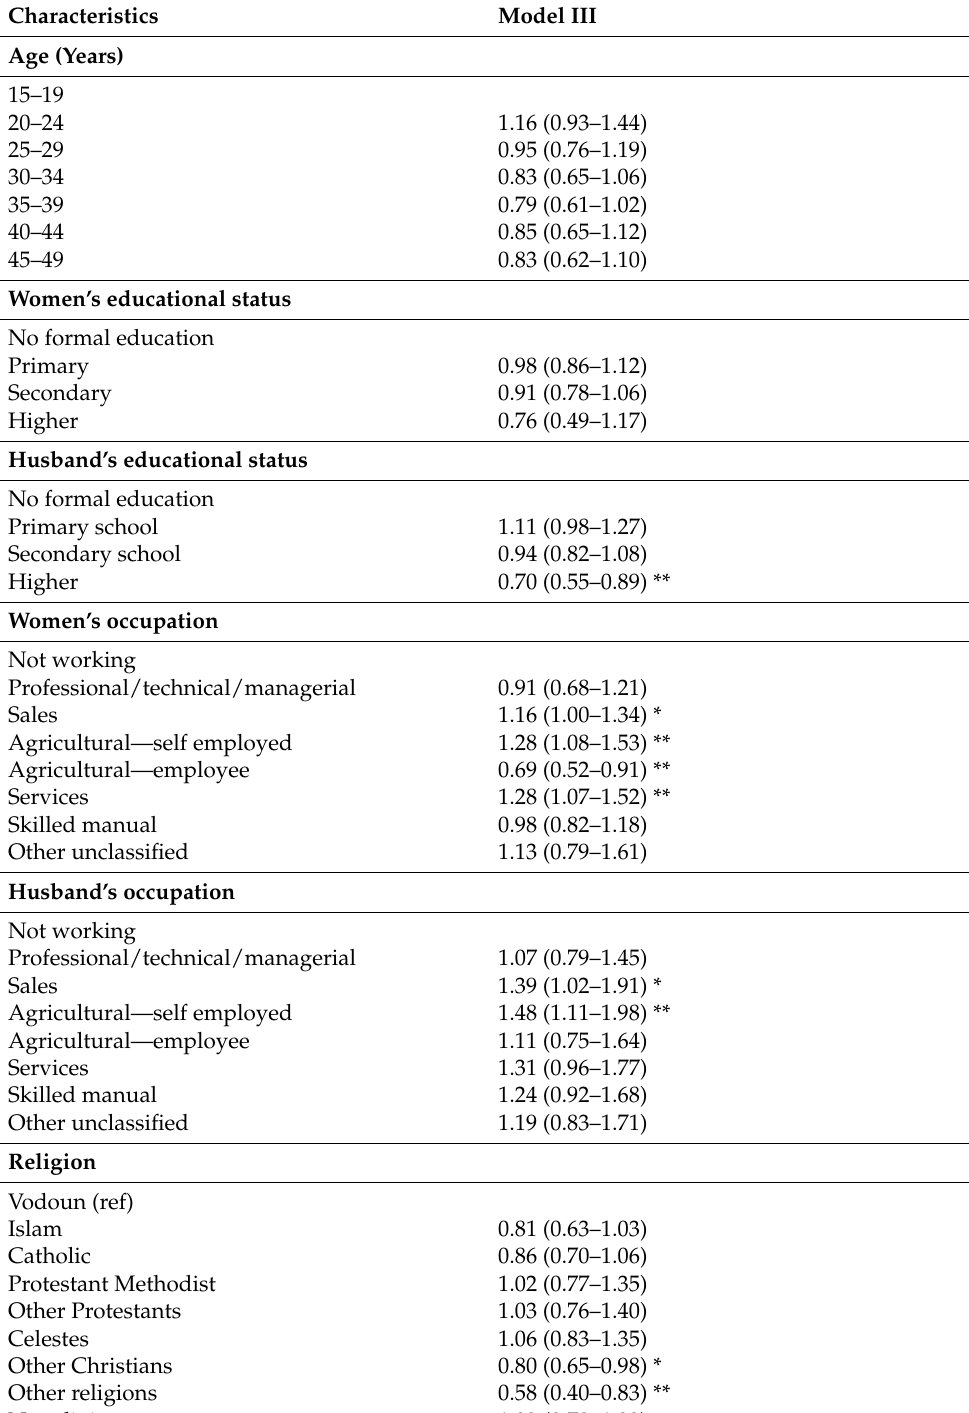
Table 1. Multilevel multivariable logistic regression results for healthcare access problems and its associated factors among women in the reproductive age groups: Evidence from 2017/18 Benin Demographic and Health